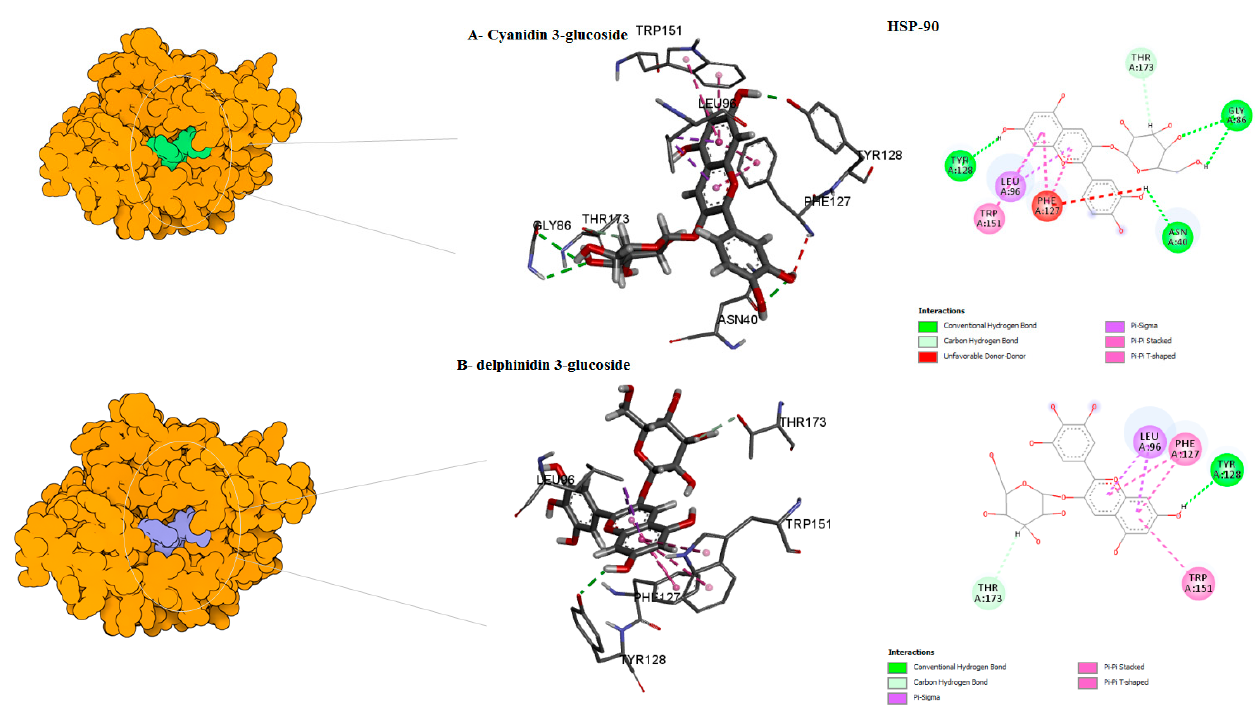
Figure 6. Predicted binding mode for Hsp90 with cyanidin 3-glucoside ID–1 and delphinidin 3- glucoside D/ID.